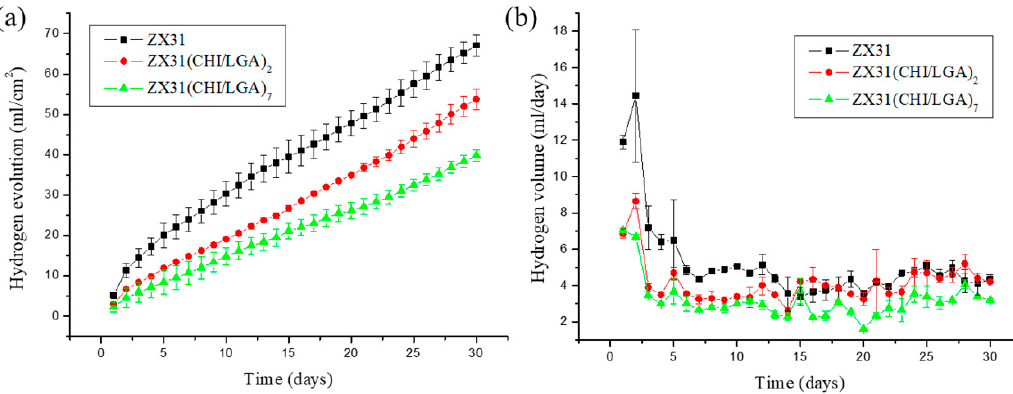
Figure 5. Volume of hydrogen for each of the specimens during a 30-day immersion test in SBF: ( a ) hydrogen evolution process of uncoated ZX31, ZX31(CHI/LGA) 2 , and ZX31(CHI/LGA) 7 specimens immersed in an SBF solution at 37 ± 0.2 °C for 30 days; ( b ) H 2 released per day.